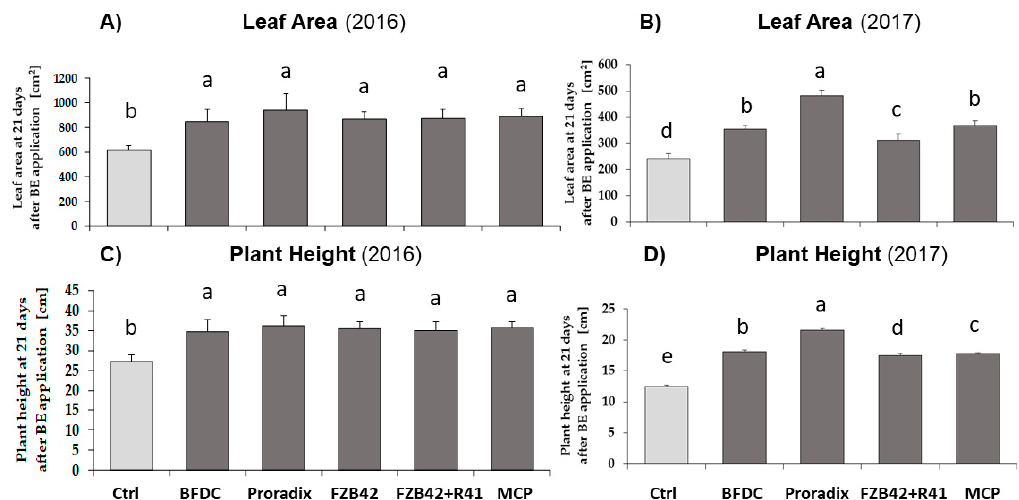
Figure 1. Leaf area ( A , B ) and plant height ( C , D ) of tomato cv Primadona F1 during the nursery phase at 43 days after sowing. Columns represent means ± standard deviation ( n = 4 with each 10 plants as subsamples). Significant treatment differences (Tukey test, p ≤ 0.05) are indicated by different characters.